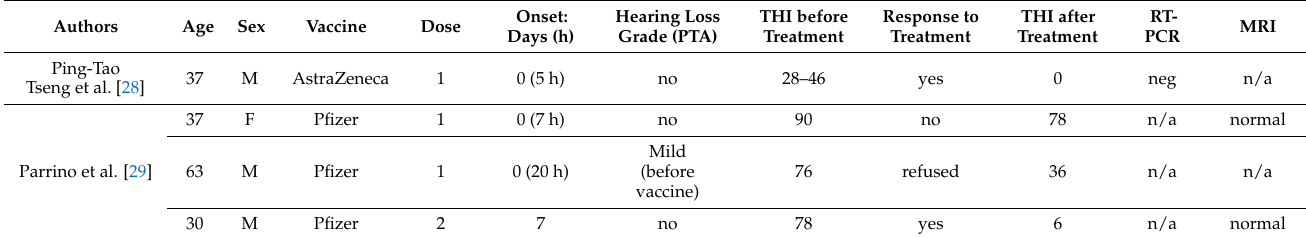
Table 2. Tinnitus as COVID-19 adverse events following immunization